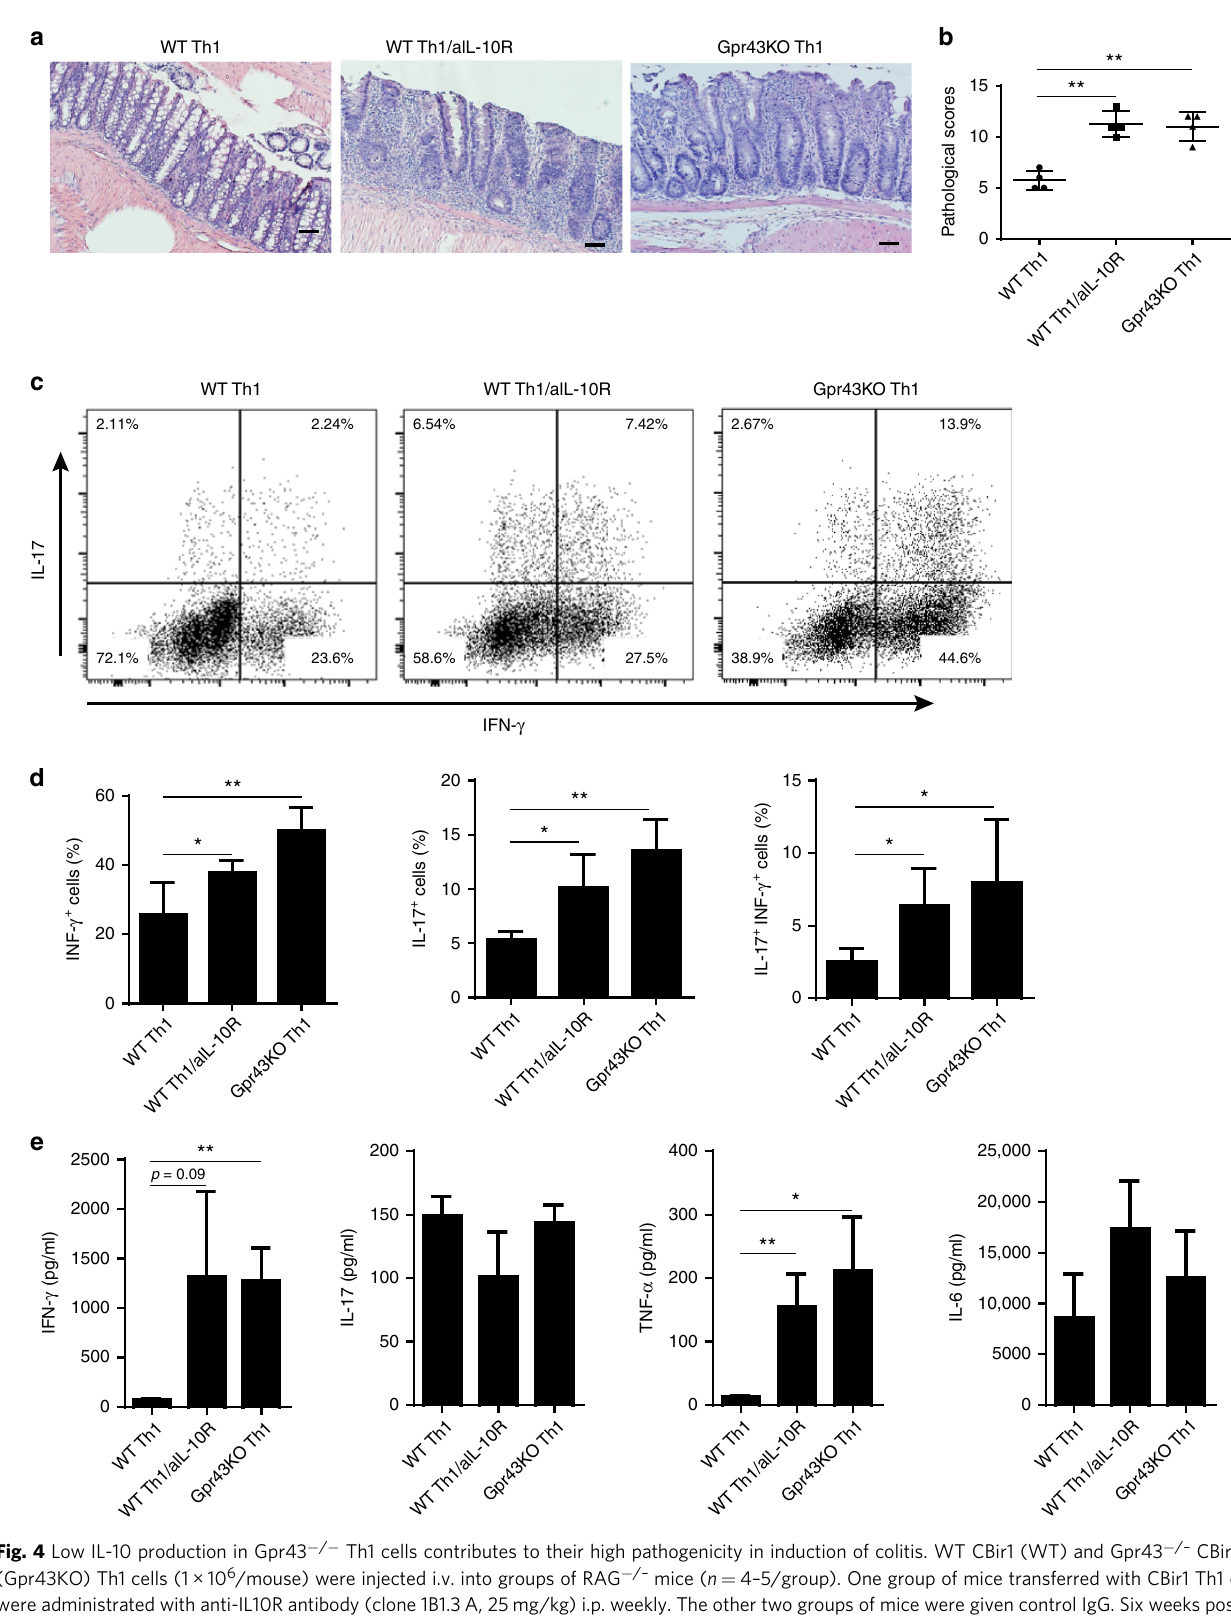
Fig. 4 Low IL-10 production in Gpr43 − / − Th1 cells contributes to their high pathogenicity in induction of colitis. WT CBir1 (WT) and Gpr43 − / – CBir1 Tg (Gpr43KO) Th1 cells (1 × 10 6 /mouse) were injected i.v. into groups of RAG − / – mice ( n = 4 – 5/group). One group of mice transferred with CBir1 Th1 cells were administrated with anti-IL10R antibody (clone 1B1.3 A, 25 mg/kg) i.p. weekly. The other two groups of mice were given control IgG. Six weeks post-T- cell transfer, the severity of intestinal in fl ammation was assessed. a , b Colonic histopathology ( a ) and histological scores ( b ) are shown. Scale bar, 100 μ m. ** p < 0.01 Mann – Whitney U -test. c LP CD4 + T-cell cytokine production was determined by fl ow cytometry. d Bar charts of the percentage of cytokine- expressing CD4 + T-cells. e Colonic tissue cytokine production after 24 h of culture was measured by ELISA. Data are shown as mean ± SD of twelve mice samples pooled from three experiments. * p < 0.05, ** p < 0.01 one-way ANOVA